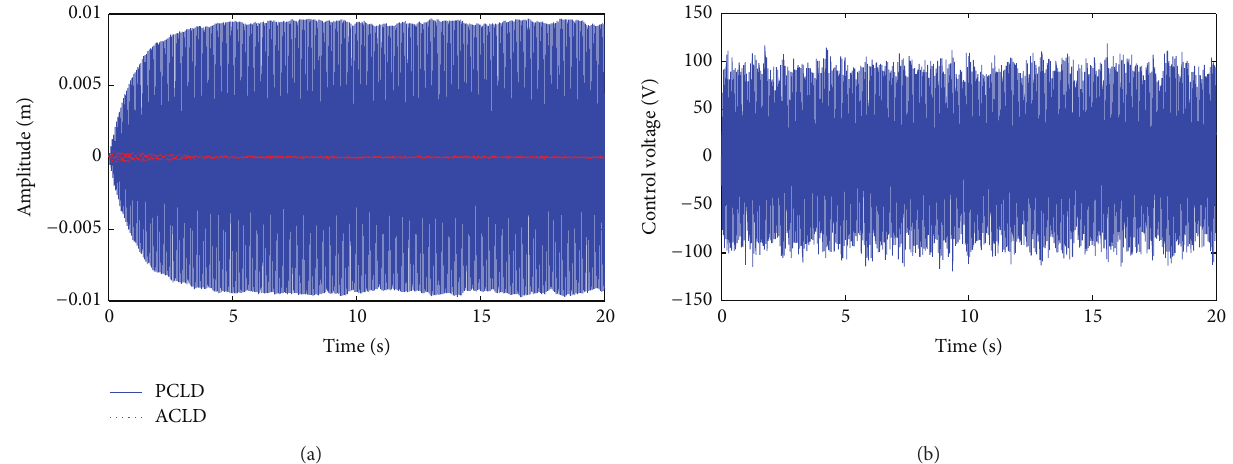
Figure 10: The displacement response for a mixed disturbance using the hybrid controller: (a) the displacement response, (b) the control